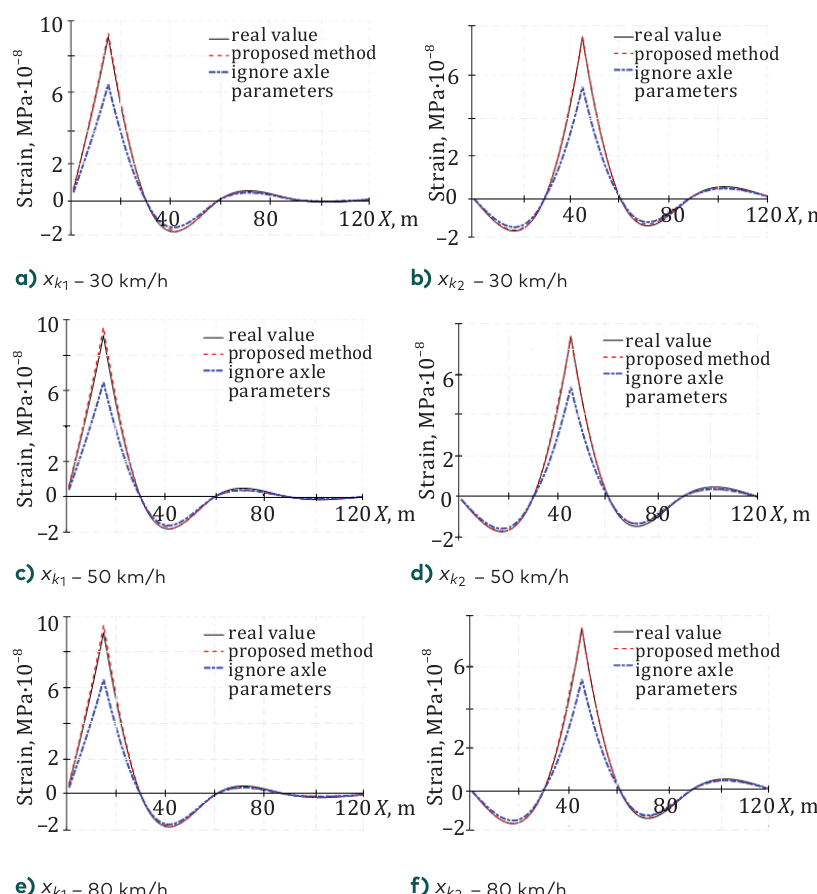
Figure 15. Comparison of modified strain influence line and the theoretical curve in different